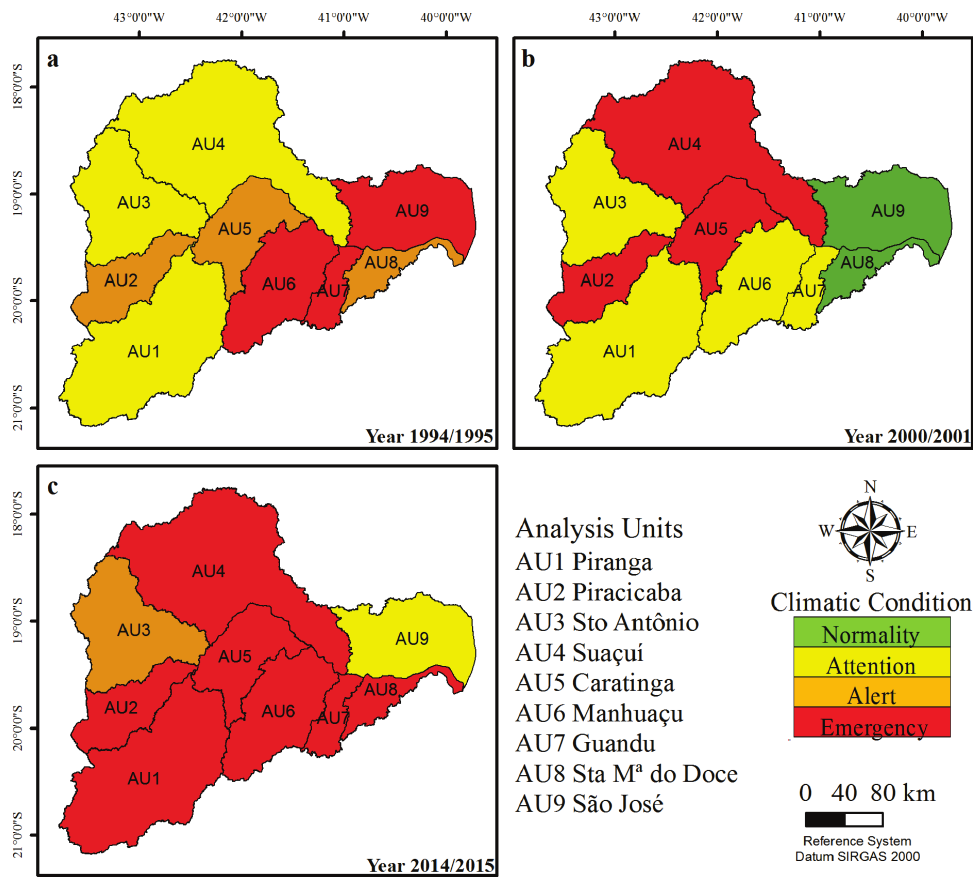
Figure 2 - Climatic conditions of the 1994/1995 ( a ), 2000/2001 ( b ) and 2014/2015 ( c ) hydrological years for the Doce river Basin